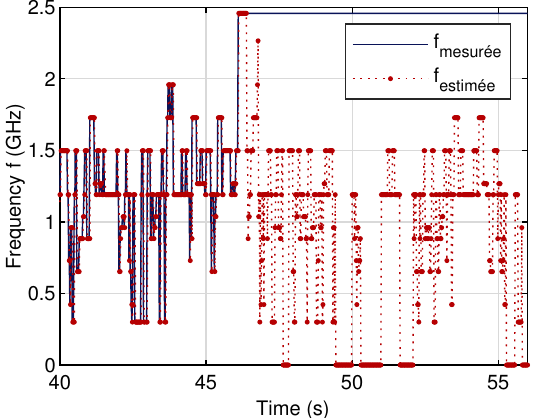
Figure 14. Estimated frequency from loads against measured frequency that is blocked at the maximum value around t = 46s.